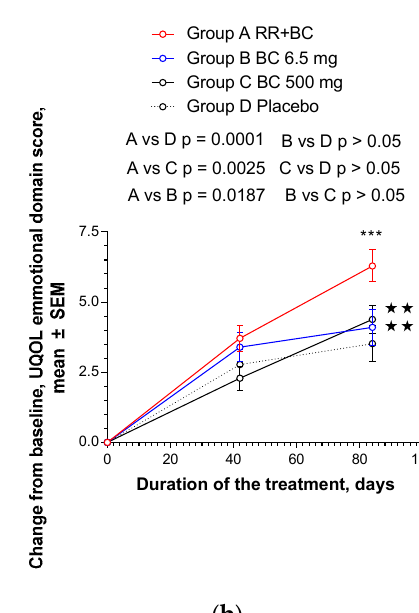
Figure A4. The change from baseline of menopause UQOL physical health domain scores (mean ± SD) over time: ( a ) -ITT analysis, ( b ) -PP analysis. Significance of difference between groups at various time points, calculated by Bonferroni post-test, is expressed by symbols * p < 0.05, ** p < 0.01, *** p < 0.001; ns: not significant (A, B, C vs. placebo) and * p < 0.05 (C vs. A), *** p < 0.001 (B vs. A).